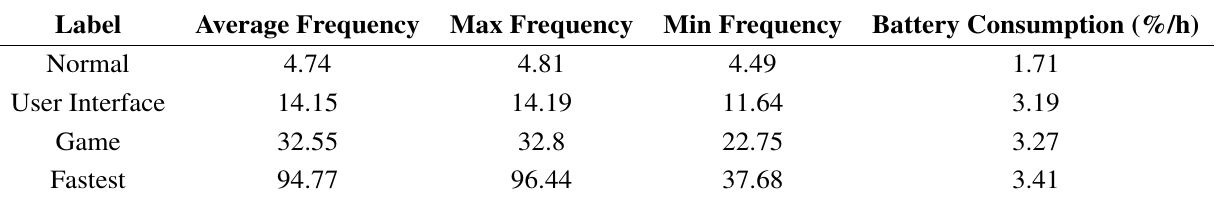
Table 6. Investigation of different sampling frequencies of Samsung Galaxy Note